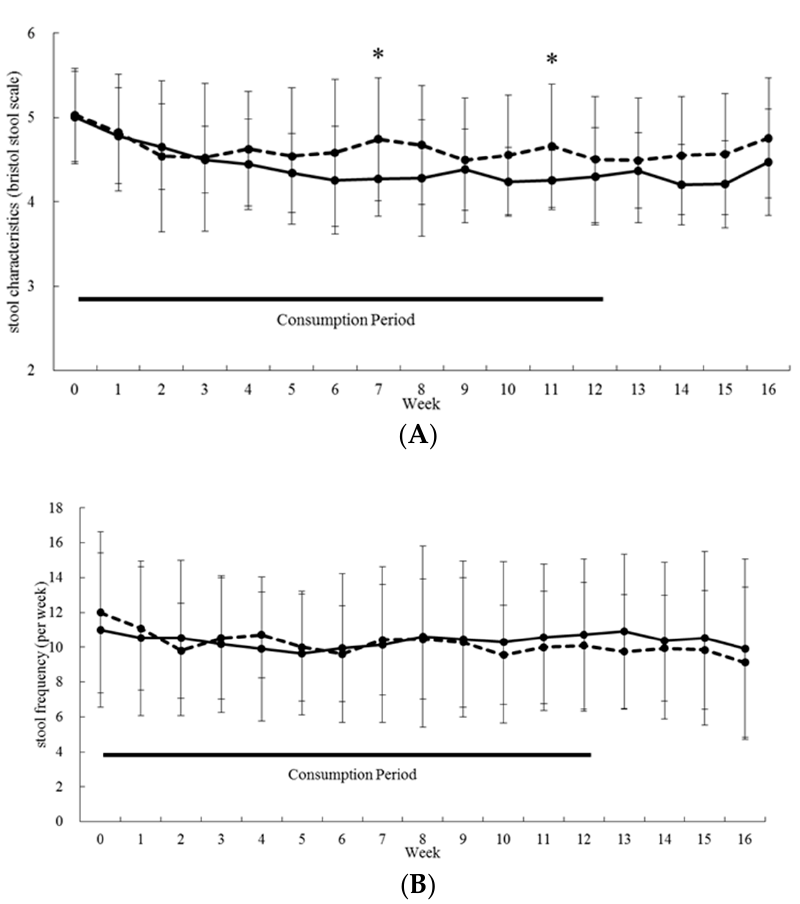
Figure 3. Effect of PHGG on primary endpoints. Stool form ( A ) and frequency ( B ) are shown. Straight lines and dotted lines denote mean values for PHGG and placebo groups, respectively. Bars show SD. PHGG group: n = 21, placebo group: n = 21. * p < 0.05, Welch’s t -test.